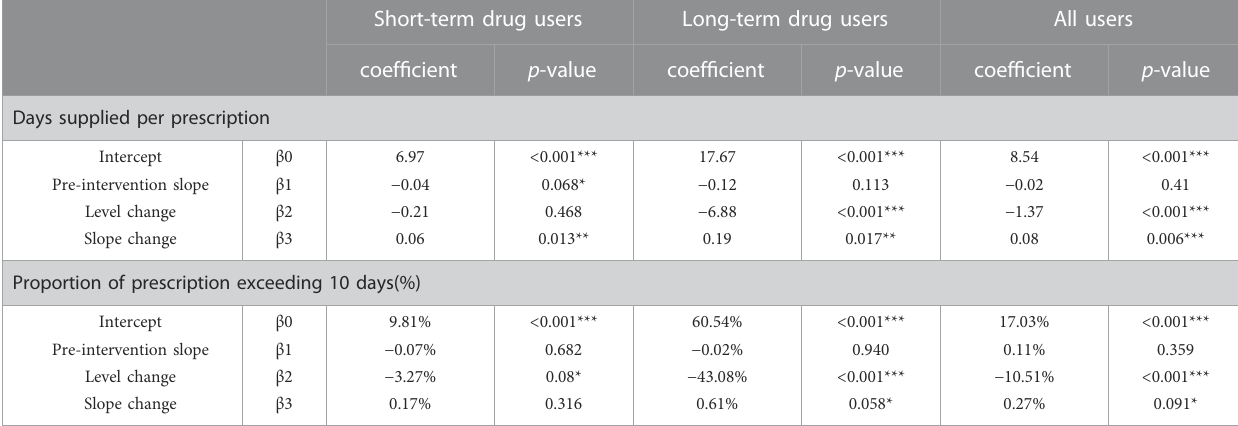
TABLE 3 Estimates from Interrupted Time-Series models of the impacts of the policy on days supplied and proportion of prescription exceeding 10